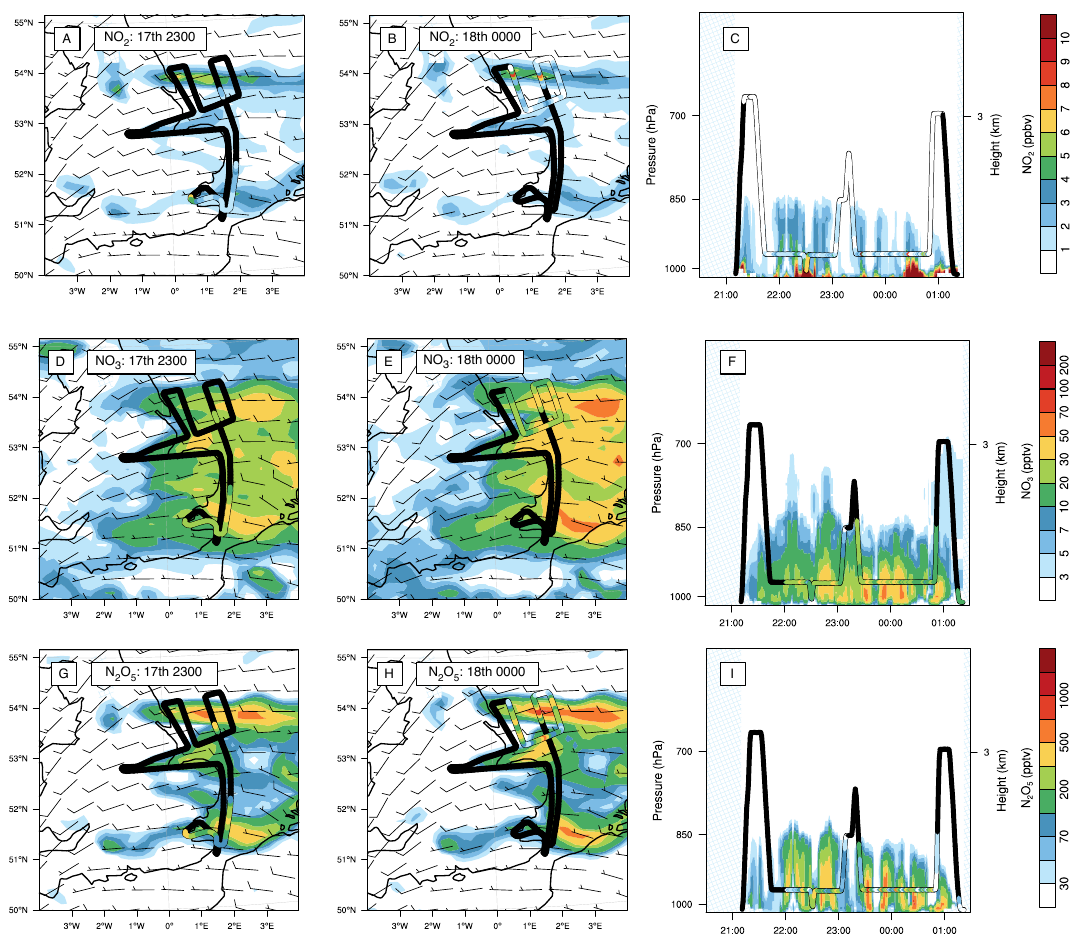
Figure 5. Comparison of NO 2 ( a–c ), NO 3 , ( d–f ), and N 2 O 5 ( g–i ) measurements with regional model fields (from the “het on” scenario) for the B535 flight. ( a ) and ( b ), ( d ) and ( e ), and ( g ) and ( h ) show model fields interpolated to 970hPa at the times indicated in each panel, compared with measurements which are made within ± 30min of that time, and within ± 10hPa of the interpolated model pressure level. ( c ), ( f ), and ( i ) show the vertical distribution of the model fields along the flight path (extracted ± 30min either side of each output time), with measurement data along the flight path. See the main text for full